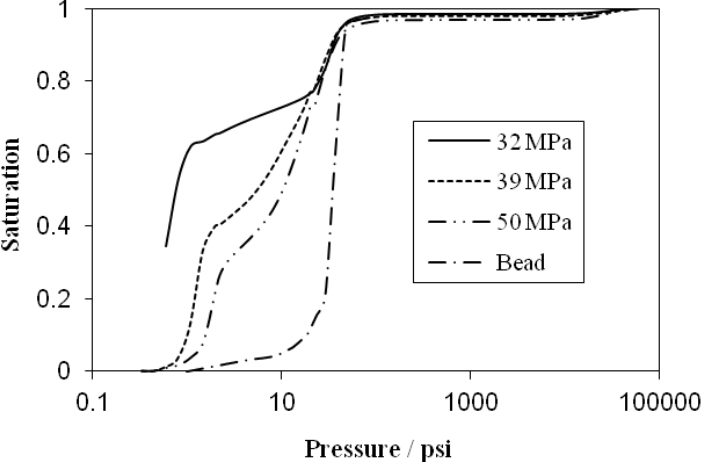
Figure 6. Saturation vs . pressure curves for Hg into porous beads and compacted